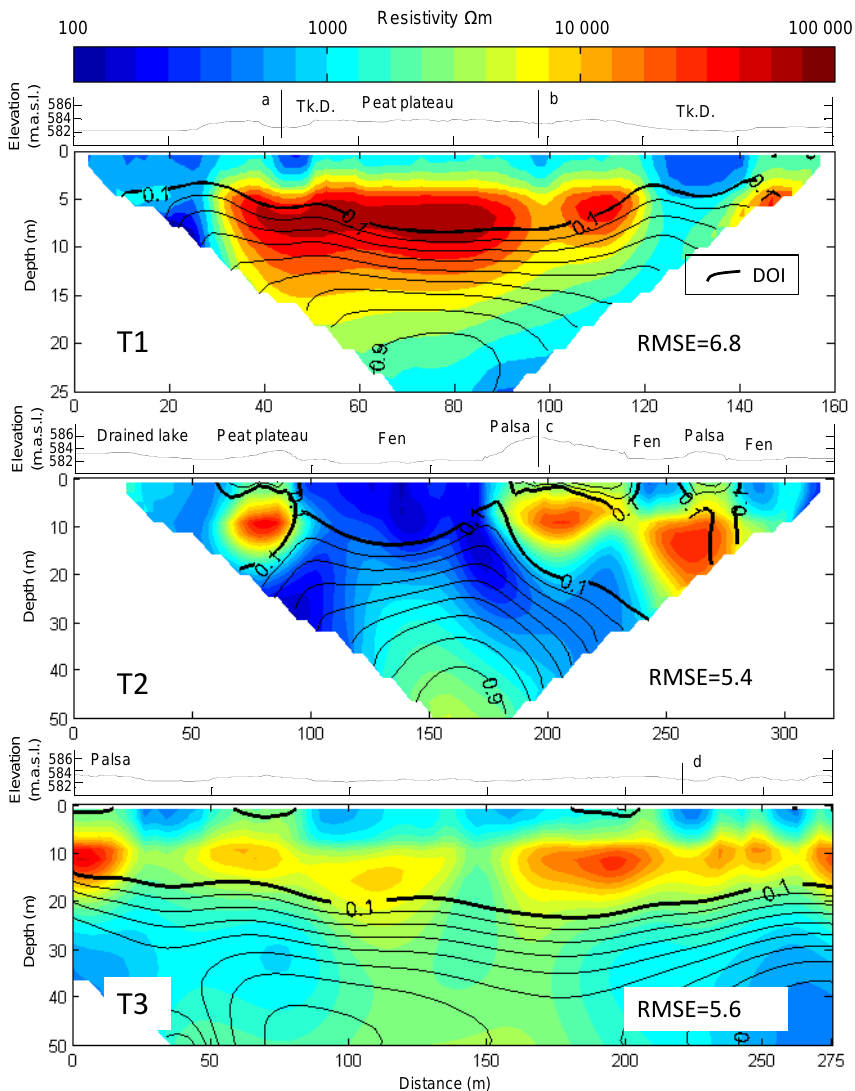
Figure 5. Elevation profiles and ERT results for T1, T2, and T3. DOI < 0.1 (black lines) indicates that the model is well constrained by the data. Landforms are indicated on top of elevation profiles along T1 and T2 (Tk.D = thermokarst depression) together with coring points in T1 (a is point 3 in Fig. 1, and b is point 4 in Fig. 1) and T3 (d is point 6 in Fig. 1) as well as the 10m borehole in T2 (c is point 1 in Fig. 1). No landforms are indicated along T3 after the first palsa (0–25m) due to the complex micro topography of hummocks and thermokarst depressions along this